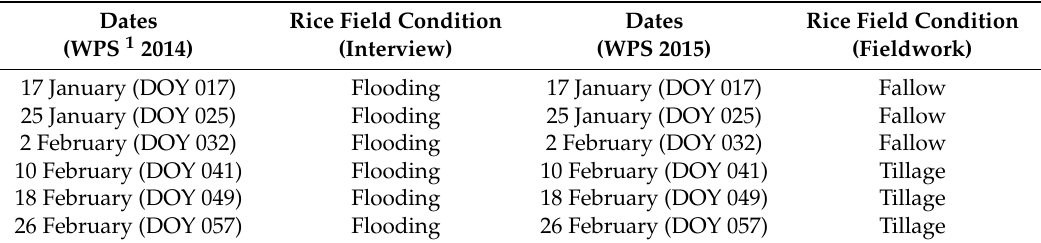
Table 1. Conditions of rice fields with flooding and rice fields with agronomic inundation in Bobos and Pangarengan villages (Legonkulon sub-district) during wet planting seasons 2013/2014 (flooding year) and 2014/2015 (dry year). Table 1 corresponds to the black rectangle in Figure